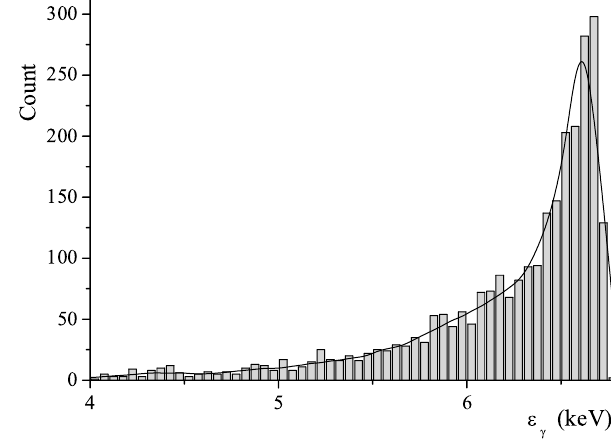
FIG. 8. Spectrum of scattered photons within 1 mrad collima- tion angle. Electron beam energy E ’ (cid:1) 10 (cid:12) , initial emittances of injected beam . (cid:1) 7 (cid:14) 10 (cid:16) 6 m . s